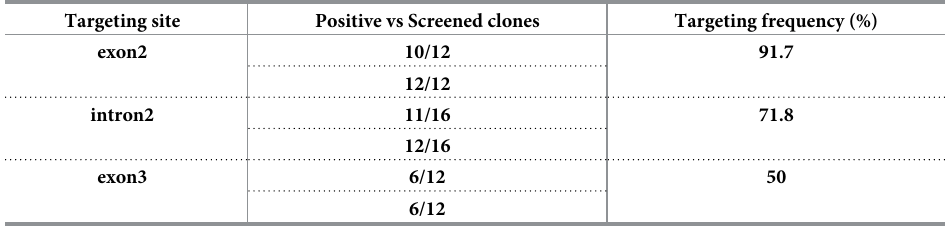
Table 3. Gene targeting frequency at distinct targeting sites of the Myh9 locus in mouse ES